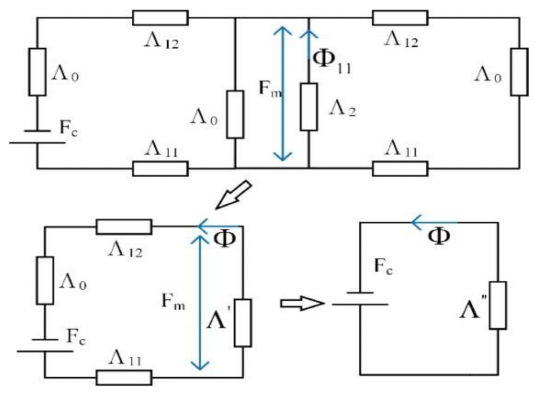
Figure 7. The equivalent magnetic circuits of the magnetic flux generated by an adjacent